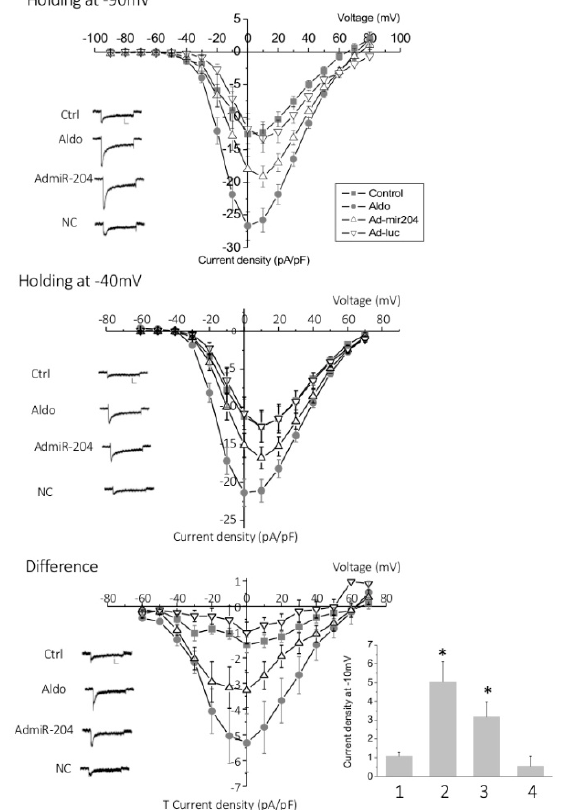
Figure 4. T-type and L-type Ca 2+ currents are increased upon miR-204 overexpression. The graphs show the current density-voltage relationship obtained from whole cell patch clamp experiments in control (Ctrl), aldosterone (1 µ M for 24 h)-treated (Aldo), miR-204 adenovirus-infected (Admir-204), and luc-adenovirus-infected cardiomyocytes (Ad-luc) obtained from holding potential at − 90 mV (upper panel), reflecting the total (L-type and T-type) calcium current, or at − 40 mV (middle panel), reflecting L-type current. The difference plots, reflecting T-type Ca 2+ currents, are shown in the lower panel. Traces are representative examples of current recordings at –20 mV depolarization steps. Scale bars are 100 pA (vertical) and 25 ms (horizontal). Data are means ± SEMs ( n = 11–16). The bar graph represents the means + SEMs of the T current density recorded at − 10 mV in control ( 1 ), aldosterone (1 µ M for 24 h)-treated ( 2 ), miR-204 adenovirus-infected ( 3 ), and luc-adenovirus-infected ( 4 ) cardiomyocytes (* p < 0.05).